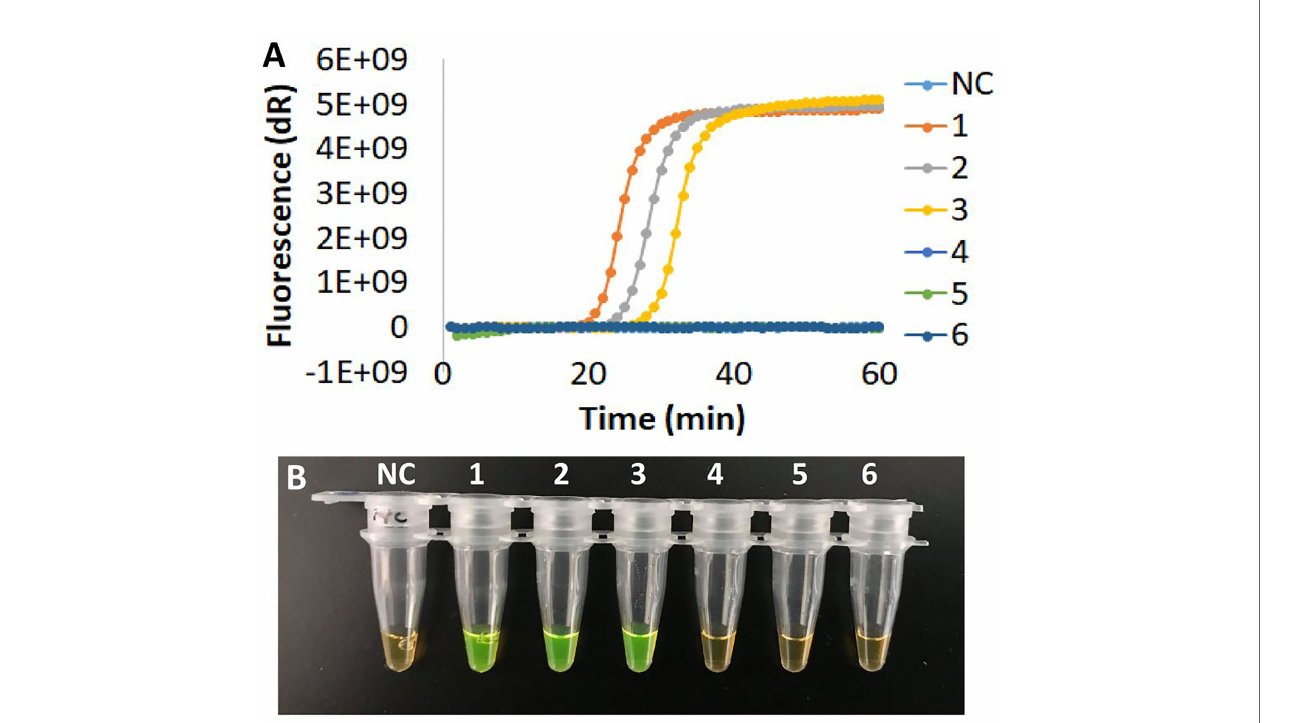
FIGURE 5 | The effect of Cod-UNG-rRT-LAMP assay using boiling samples. (A) Fluorescence detection method, (B) direct visual detection method. In both (A) and (B) , a serial 10-fold dilution of a culture virus in negative throat swabs sample was prepared by boiling method at 95°C for 5 min. NC, negative control, 1: 10 2 times dilution, 2: 10 3 times dilution, 3: 10 4 times dilution, 4: 10 5 times dilution, 5: 10 6 times dilution, 6: 10 7 times